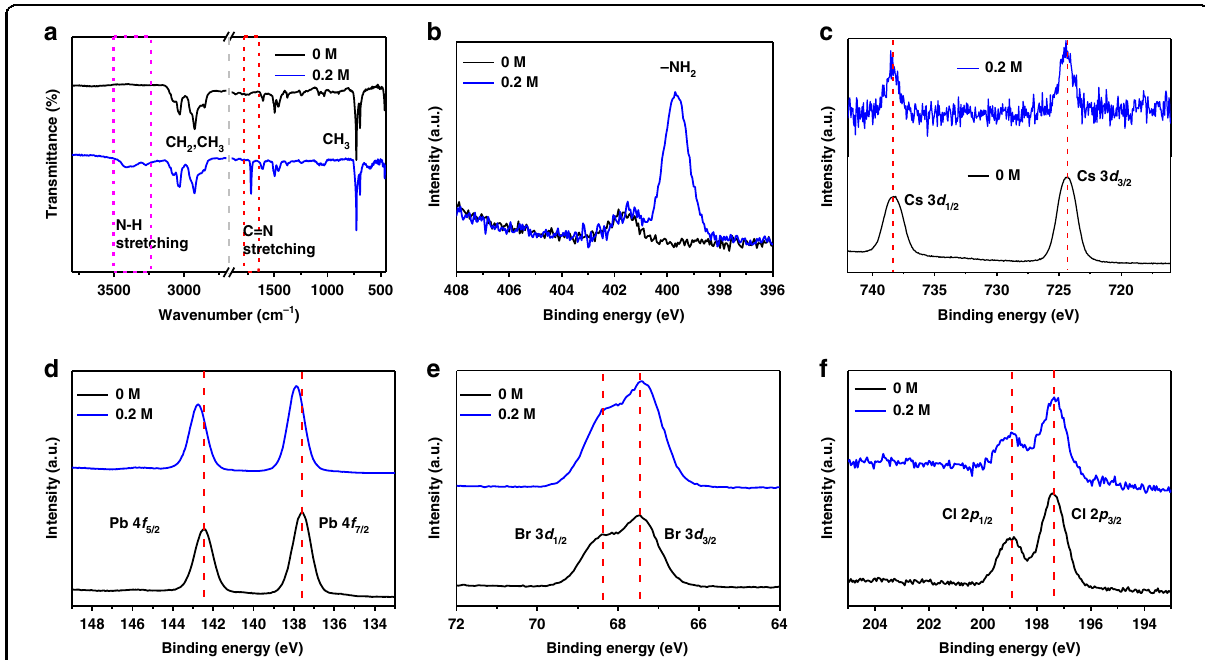
Fig. 3 Chemical analysis of QDs. a FTIR spectra of pristine and FA cation doped QDs. XPS spectra of pristine and FA cation doped, N 1 s ( b ), Cs 3 d ( c ), Pb 4 f ( d ), Br 3 d ( e ), and Cl 2 p ( f